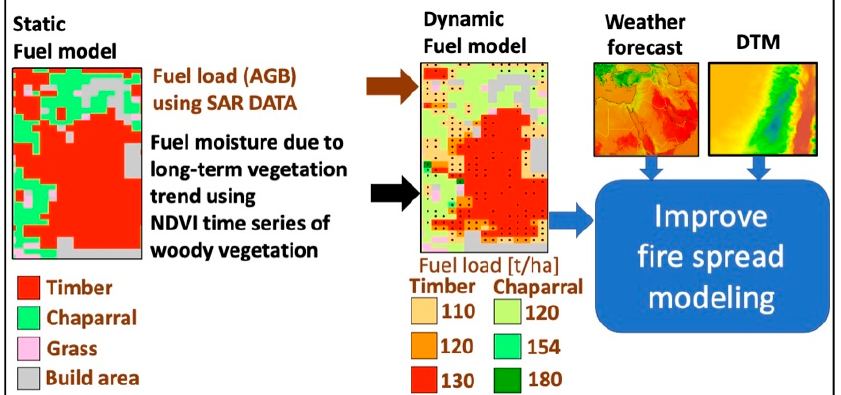
Figure 1. Flowchart summarizing the steps of this study.